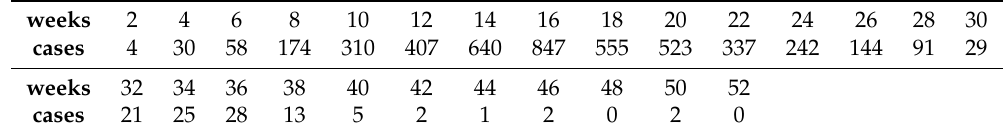
Table A3. Biweekly reported infections of measles in 1961 in Portsmouth, UK [57]. weeks